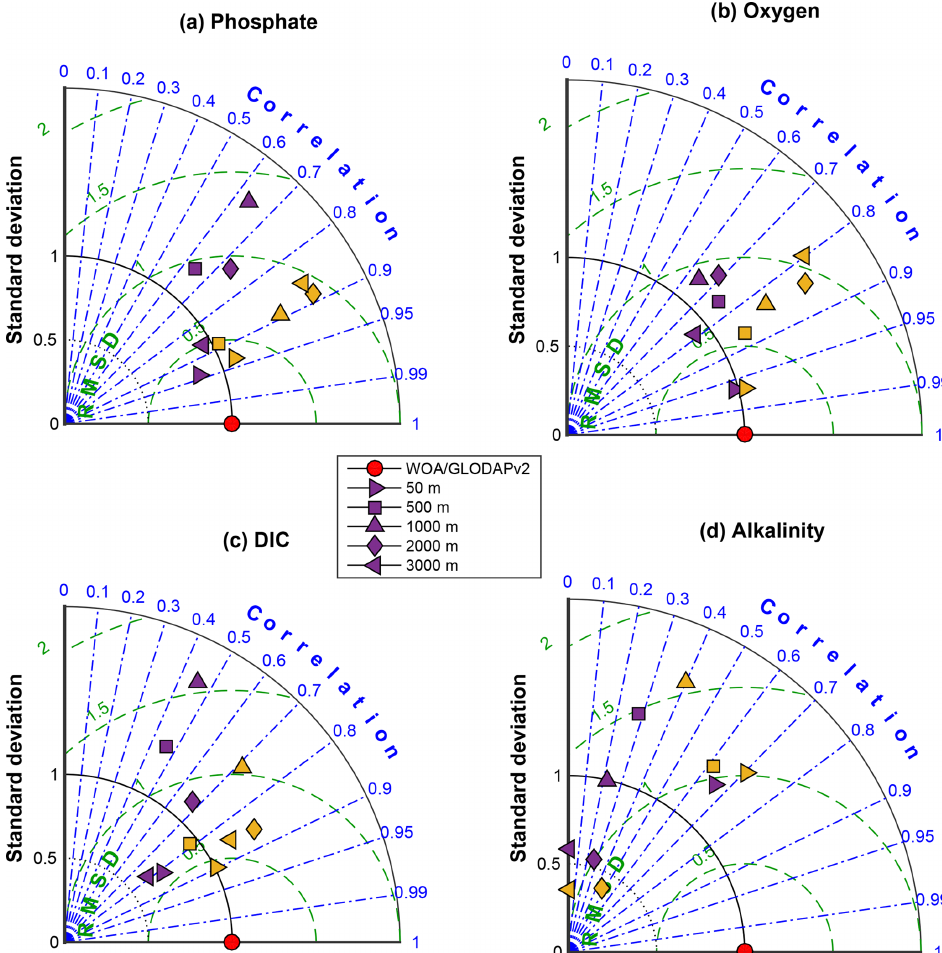
Figure 10. Taylor diagrams summarizing the statistical performance of the climatology fields of (a) phosphate, (b) oxygen, (c) dissolved inorganic carbon, and (d) total alkalinity in the water column relative to the observations (Garcia et al., 2014a, b; Lauvset et al., 2016). All standard deviations are normalized to the respective values from the observations. Different symbols represent model–data comparison at different depths from 50 to 3000m. Purple markers represent values from NorESM1-ME pre-industrial simulations (Tjiputra et al., 2013), whereas yellow markers depict the NorESM1-F, and red circles indicate